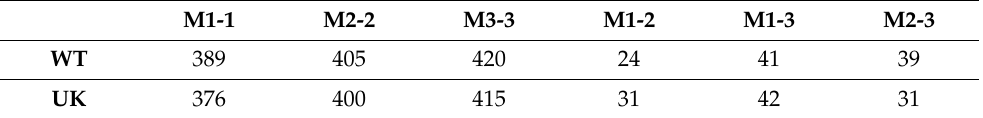
Table 2. Number of direct protein–protein hydrogen bonds recurring for more than 80% of simulation time in Monomer 1, 2, and 3. Intra-monomer interactions are reported in the first three columns, while the inter-monomer ones are in the last three